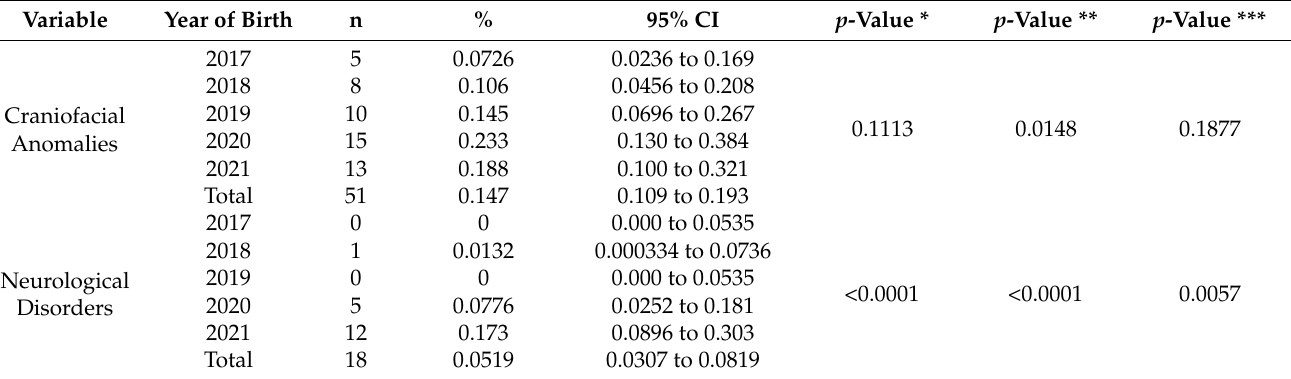
Figure 2. Relative frequencies of RIHL in newborns who underwent UNHS, by year of birth. Florianópolis, SC, 2017 to 2021 (n = 34,801). Table 2. Relative frequency of craniofacial anomalies and neurological disorders in newborns in UNHS, by year of birth. Florian ó polis, SC, 2017 to 2021 (n =